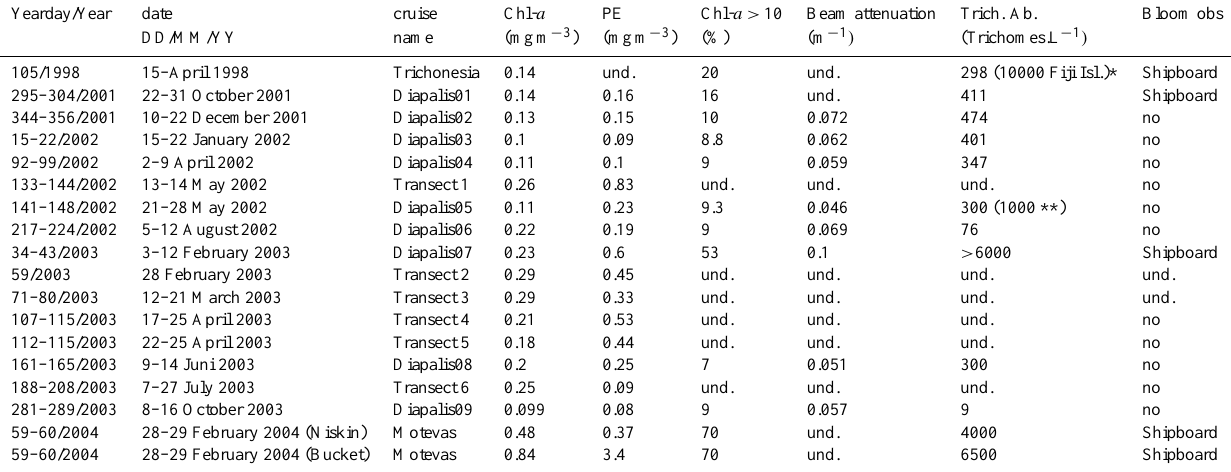
Table 2. Average in situ observations in the surface layer (3m Niskin bottle) of filamentous cyanobacteria during the DIAPAZON Program from Ten´orio (2006), the Motevas cruise, and in surface bucket samples during the transects made on the French Navy ships from New Caledonia to Tr 1: Vanuatu, Tr 2: Walpole, Tr 3: Vanuatu, Tr 4: Vanuatu, Tr 5: Fiji, Vanuatu, Tr 6: Wallis and Futuna and Vanuatu. Chl- a = chlorophyll- a ; PE = phycoerythrin; Chl- a > 10 = percentage of Chl- a associated with the > 10µm fraction, Cp = attenuation coefficient (m − 1 ) . Und: